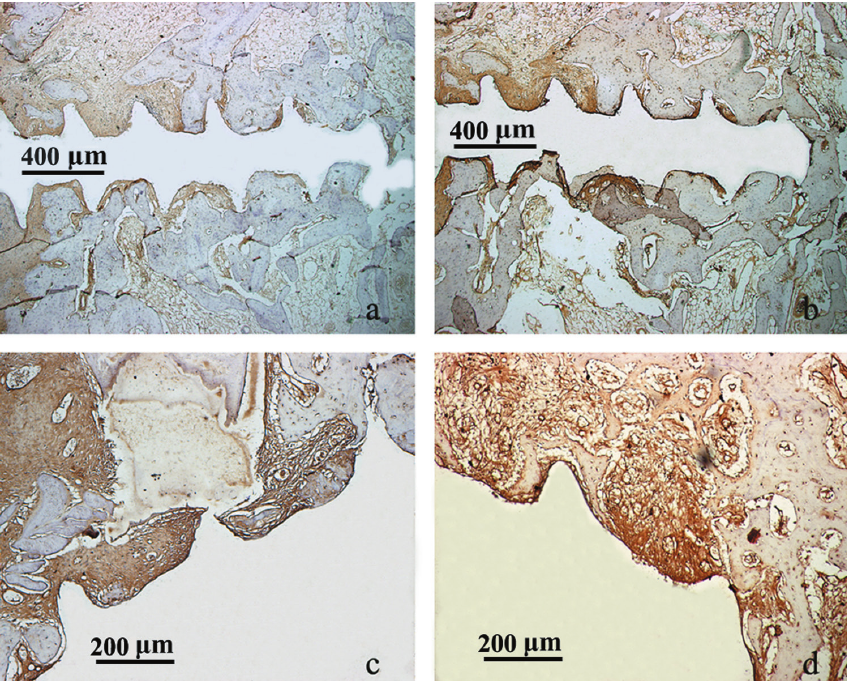
Figure 7- Immunohistochemical staining of osteocalcin (OC) in beagle mandible sections from test (a and c) and control groups (b and d), during weeks 3 and 8. The expression of OC in control group (b) was stronger than in test group (a) at week 3. The expression levels of OC in both groups reached peak values at week 8 (c, d). No statistically significant differences were observed between the two groups at week 8. Magnification: a and b; 40x, c and d;